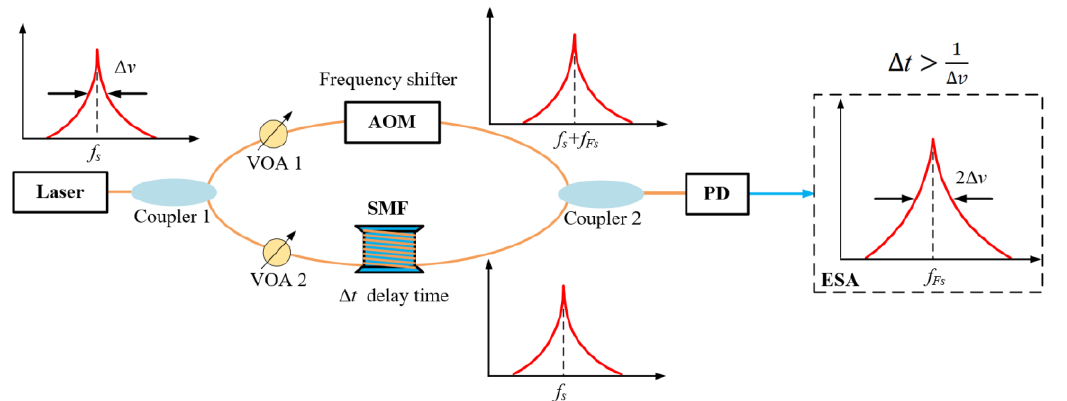
Figure 2. Experiment setup for measuring laser linewidth. VOA: variable optical attenuator; AOM: acousto-optic modulator; PD: photoelectric detector; ESA: electrical spectrum analyzer.